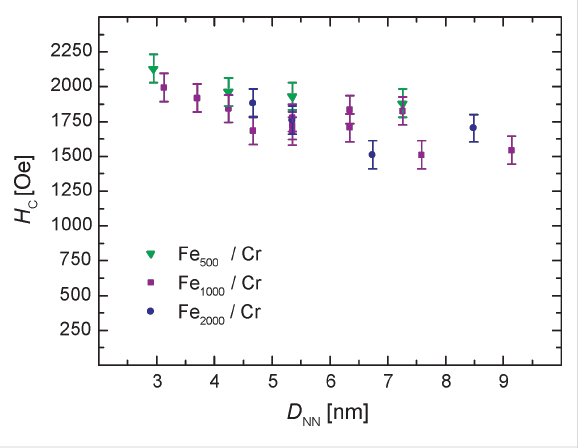
Figure 3: H c versus D NN for Fe x /Cr samples. H c mainly depends on D NN , no clear effect of the cluster size is visible in the investigated region.